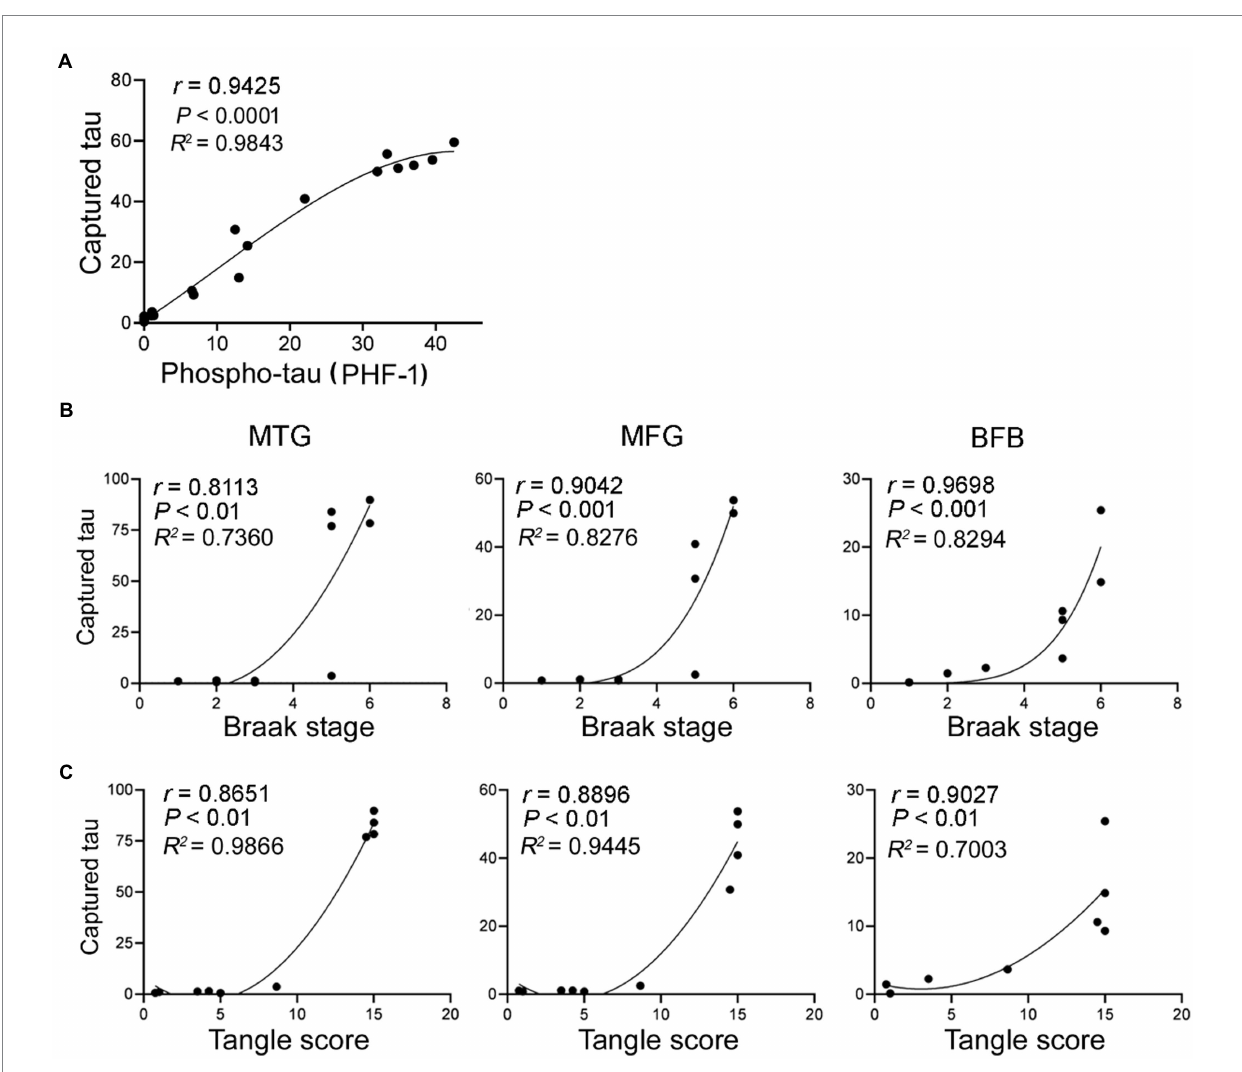
FIGURE 3 Tau seeding activity assessed by the capture assay is positively correlated with phospho-tau, Braak stage and tangle score. The levels of tau captured by brain extracts from the three brain regions of AD and control cases determined in Figure 2F were plotted against the levels of phospho-tau (A) as determined in Figure 2C, Braak stage (B) and tangle score (C) . The Spearman correlation and non-linear regression were